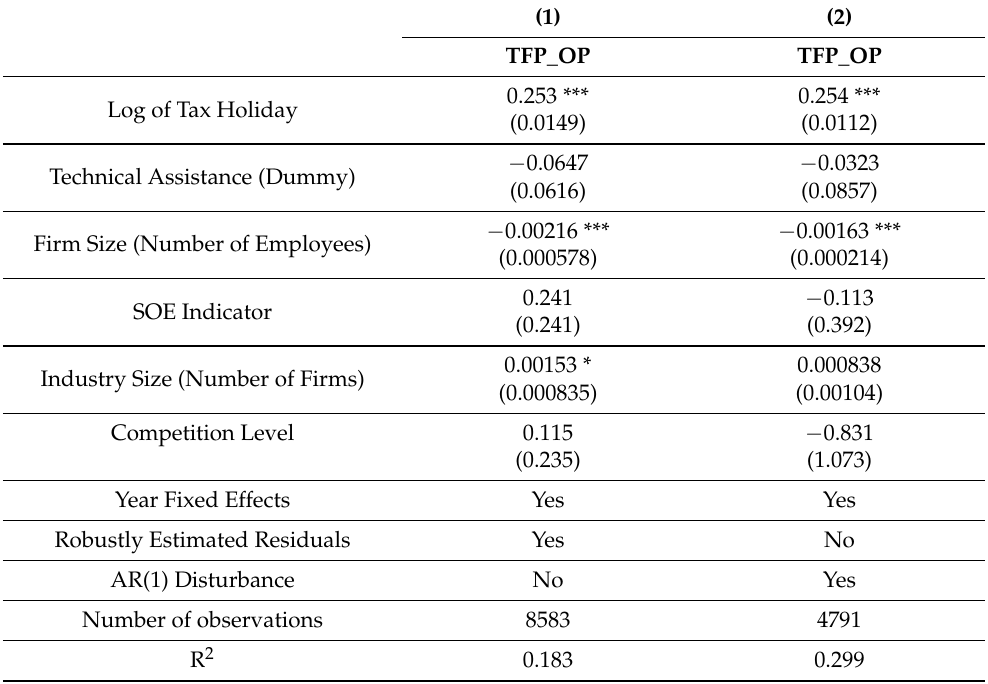
Table A10. Corrected